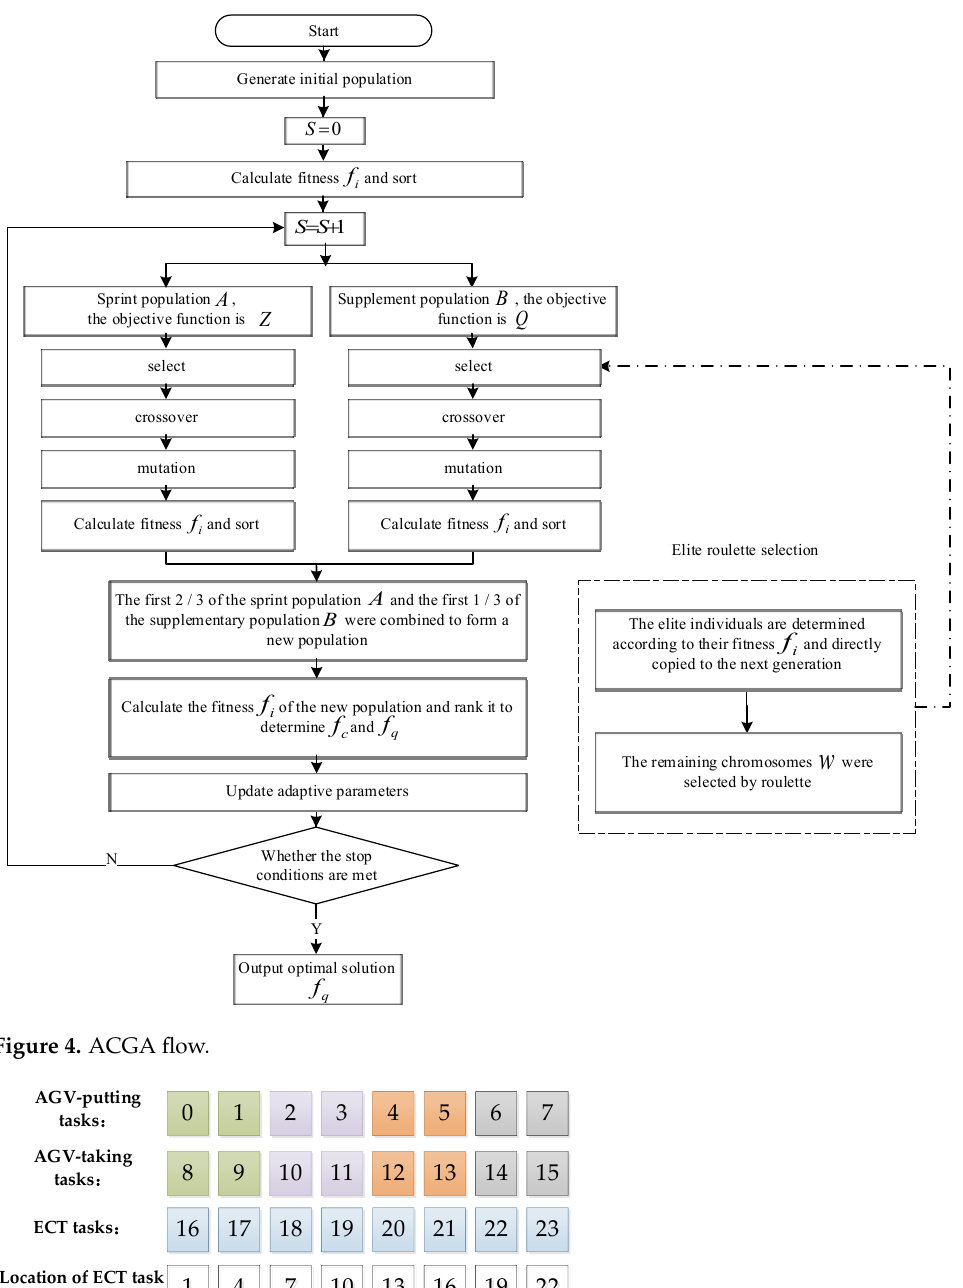
Figure 5. Initial chromosome.